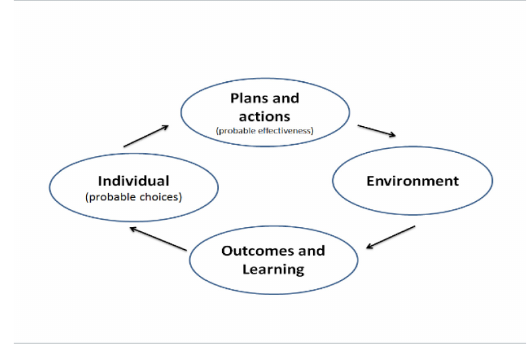
Fig. 1. Individual and Environment (Adapted from Matthews et al.,